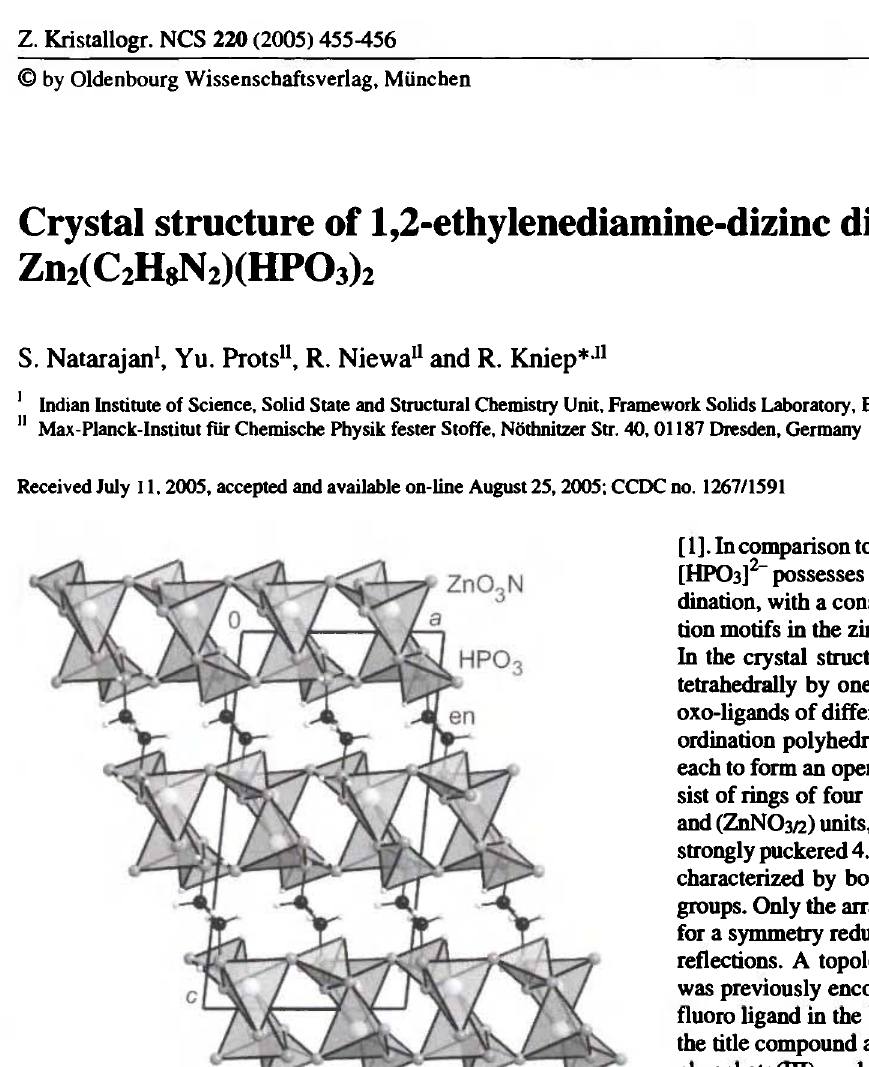
Table 1. Data collection and handling.